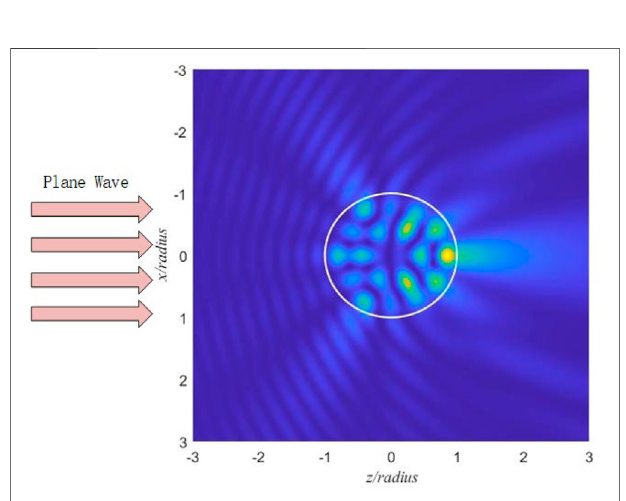
FIGURE 11 | The intensity distribution of internal and near fi elds for a plasma sphere with f i = 3.1 GHz, f p = 2 GHz, and ] c = 6 GHz.